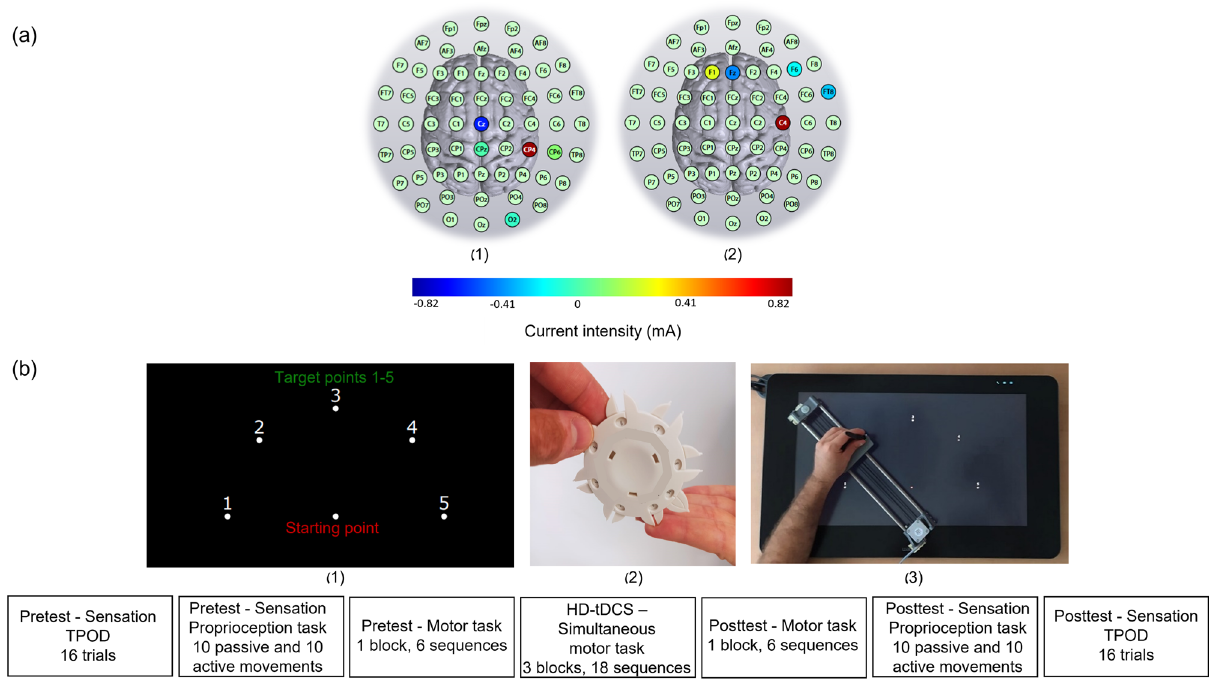
Figure 1. Course of study. ( a ) High-definition transcranial direct current stimulation (HD-tDCS) montage for maximal focal stimulation of the (1) right primary somatosensory cortex (S1) and (2) right primary motor cortex (M1) using the HD-Targets modelling software (Soterix Medical, New York, NY). The location and current intensity value of each stimulating electrode are shown. Red denotes anodal stimulation while blue denotes cathodal stimulation. ( b ) Experimental stimuli. (1) TPOD = Two-point orientation discrimination. The prongs were oriented randomly either across or down (trial-by-trial) to the left index and little fingers. (2) General setup of the proprioception task. The non-dominant left arm of the participant that held the stylus was placed on a custom-made device. The participants were required to reproduce a reaching movement from the starting position to target 2, with their eyes closed, after being passively moved by the device. This was repeated 10 times. (3) General setup of the motor task. Note that in this figure, for clarity, the targets and numbers are shown 3 times their relative size compared to those shown in the